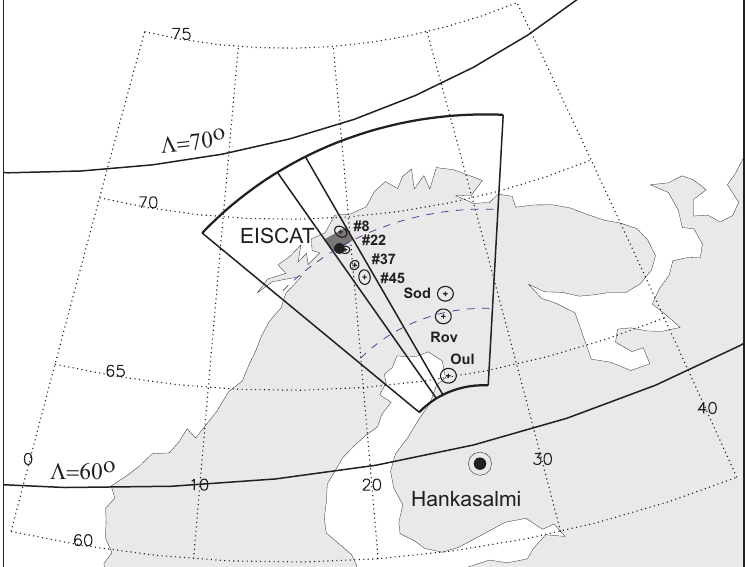
Fig. 1. Field-of-view of the Hankasalmi CUTLASS HF radar for ranges in between 400 and 1200km at the height of 300km. Dashed lines are 600 and 900km slant range marks. The outlined sector is the location of beam 5 with the shaded area corresponding to the range bin 16. The solid dot shows the area where ionospheric parameters were measured by the EISCAT incoherent scatter radar. Circles with pluses inside indicate the field-of-view for the Finnish riometers at a height of 90km. Ellipses with pluses indicate the beam projections at 90km for the IRIS beams as indicated. Also shown are PACE lines of equal magnetic latitudes of 3 = 60 ◦ and 3 = 70 ◦